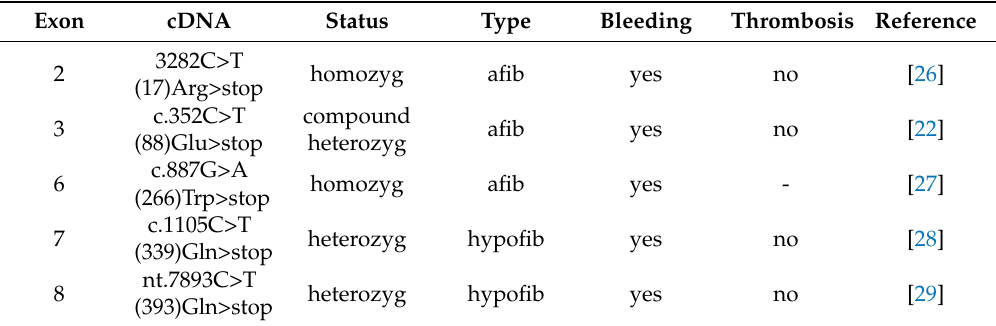
Table 3. Nonsense mutations in the FGB